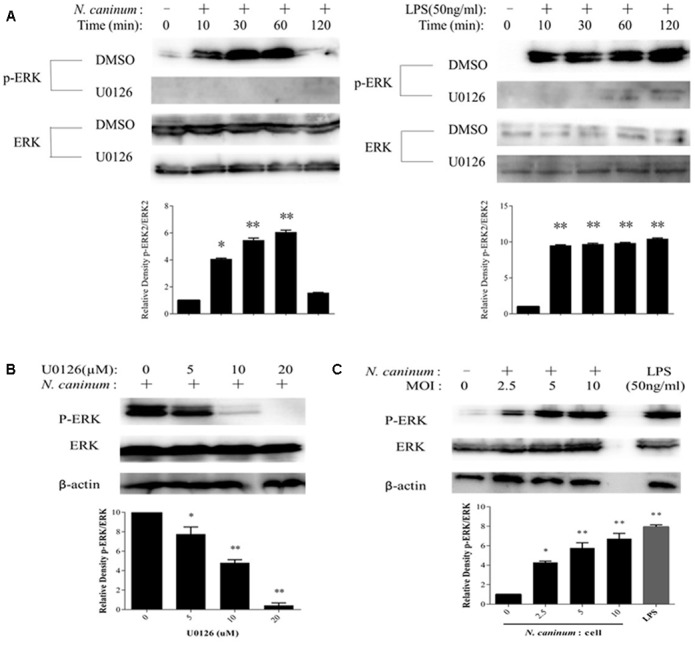
N. caninum infection induces ERK1/2 activation of PMϕ. (A) After incubated with U0126 (20 μM) or vehicles for 1 h, PMϕ were treated with freshly purified N. caninum-1 tachyzoites (MOI = 10) or LPS (50 ng/ml) for different times at 37°C. (B) After incubated with U0126 (5–20 μM) or DMSO for 1 h, PMϕ were infected with NC-1 tachyzoites for 1 h at 37°C. (C) PMϕ were infected with tachyzoites with MOI of 0, 2.5, 5, and 10, respectively, or treated with LPS (50 ng/ml) for 1 h at 37°C. After treatments, cell lysates were prepared for determination of ERK1/2 phosphorylation at Thr202/Tyr204 and total ERK1/2 by Western blotting. The intensities of phospho-ERK were calculated using ImageJ (NIH) and normalized against total ERK. Results are representative of three independent experiments. Data are expressed as the mean ± SEM. ∗P < 0.05; ∗∗P < 0.01.